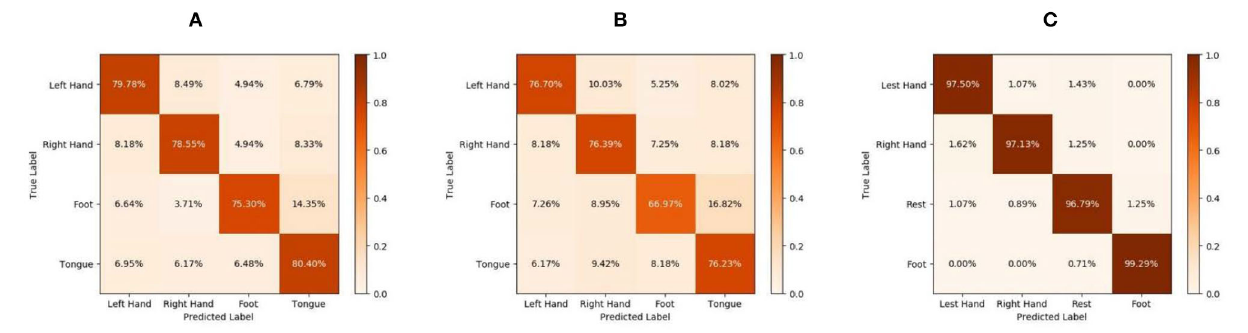
FIGURE 2 | Confusion matrices for the motor imagery (MI) task: (A) intra-subject classification of BCIIV2a, (B) inter-subject classification of BCIIV2a, and (C) intra-subject classification of high gamma dataset